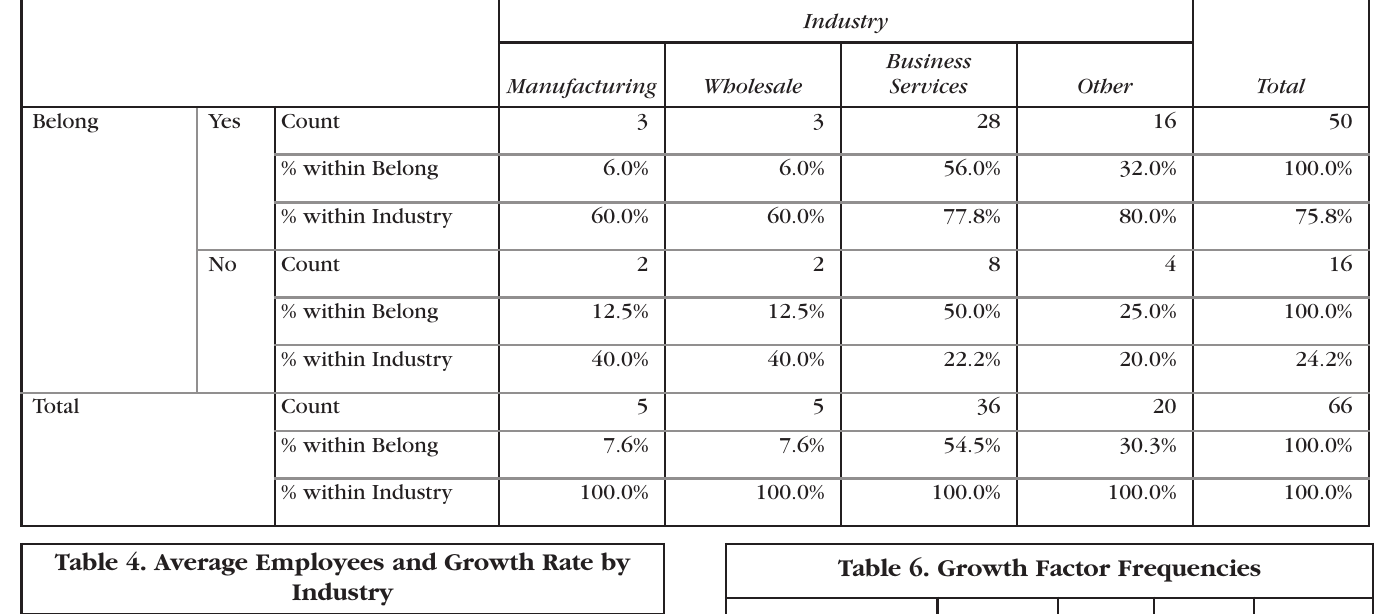
Table 4. Average Employees and Growth Rate by